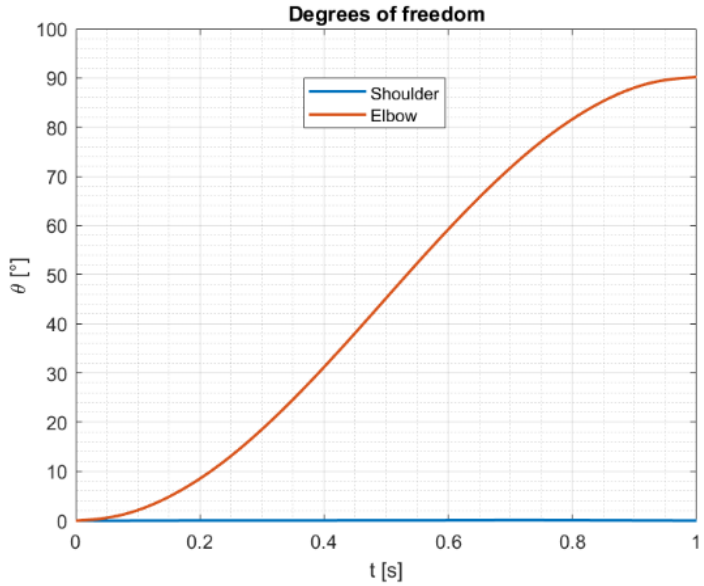
Figure 7. Arm26 degrees of freedom over time.